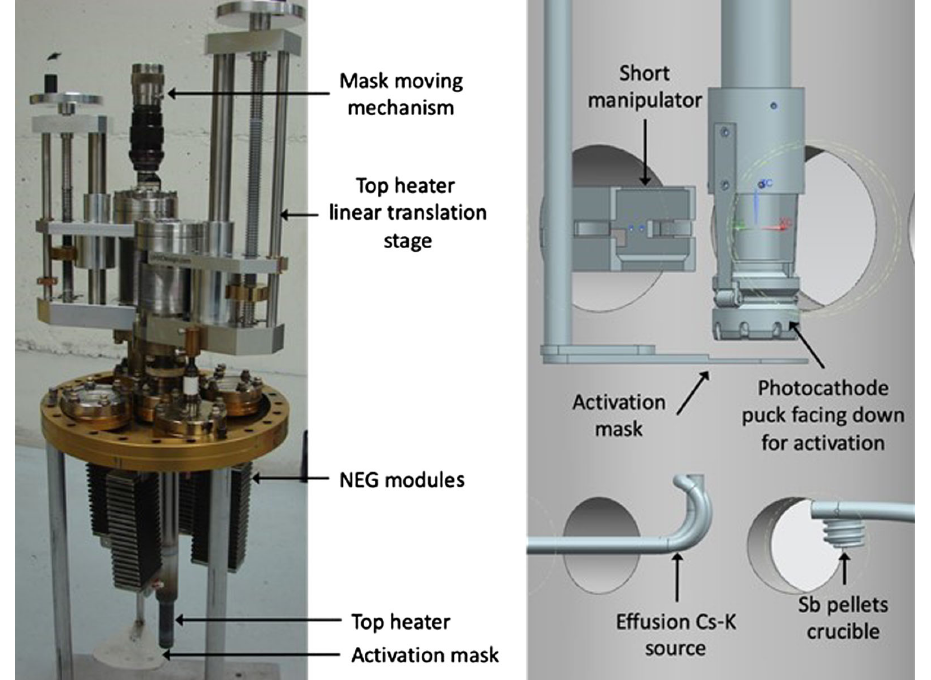
FIG. 2. Left: photograph of the top flange of the photocathode deposition chamber. Right: schematic of the photocathode deposition vacuum chamber internal components showing the photocathode puck facing down behind the mask for photocathode fabrication.